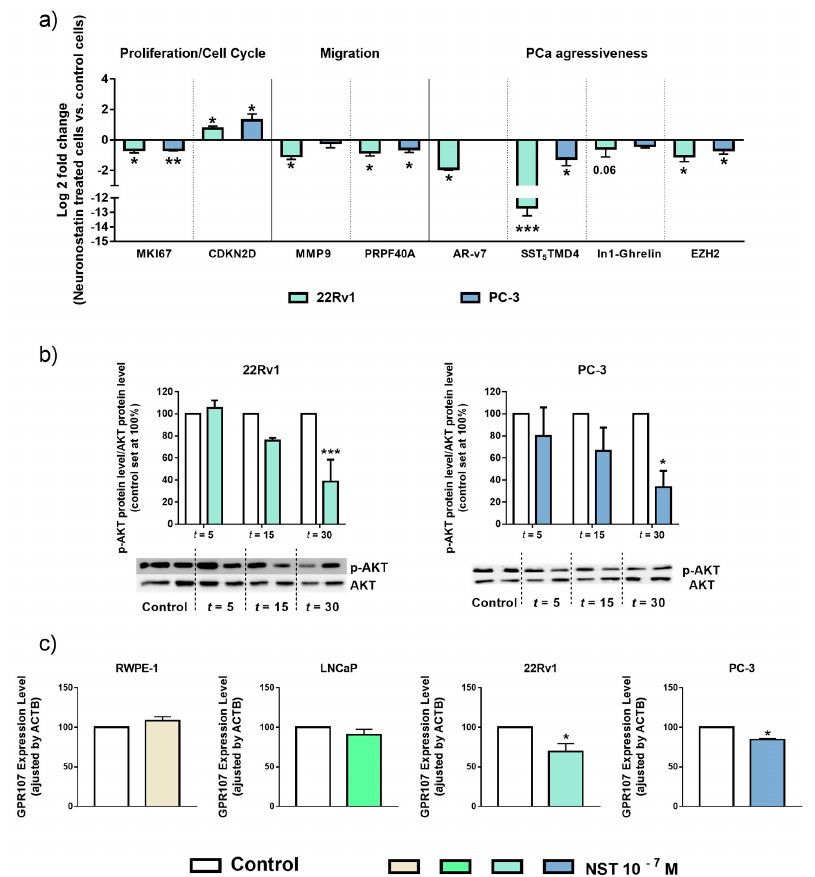
Figure 6. Molecular consequences of neuronostatin (NST) treatment in prostate cell lines. ( a ) Fold change of markers of proliferation (Marked of Proliferation Ki-67 (MKI67)), cell cycle inhibition (Cyclin Dependent Kinase Inhibitor 2D (CDKN2D)), migration (Matrix Metallopeptidase 9 and Pre-MRNA Processing Factor 40 Homolog A (MMP9 and PRPF40A, respectively)) and aggressiveness (Androgen Receptor variant 7 (AR-v7), Somatostatin Receptor 5 Transmembrane Domain 4 variant (SST 5 TMD4), Intron 1-retained ghrelin variant (In1-Ghrelin) and Enhancer Of Zeste Homolog 2 (EZH2)) in androgen-independent Prostate Cancer (PCa) cells (22Rv1 and PC-3) after NST treatment (10 − 7 M) compared to vehicle-treated cells. Messenger RNA (mRNA) levels were determined by quantitative Polymerase Chain Reaction (qPCR), adjusted by Actin Beta (ACTB) expression levels and represented as log2 of fold change of expression levels (NST-treated/vehicle-treated cells). ( b ) Protein levels of phospho-AKT in response of NST treatment in androgen-independent PCa cells (22Rv1 and PC-3) after 5 ( t = 5), 15 ( t = 15) and 30 ( t = 30) minutes of exposition. Phospho-AKT (p-AKT) levels were normalized by total AKT protein levels. Protein data were represented as percent of vehicle-treated cells (set at 100%). ( c ) GPR107 expression levels after 24 h of NST treatment in prostate cell lines. mRNA levels of GPR107 were determined by qPCR and adjusted by ACTB expression levels. Asterisks (* p < 0.05; ** p < 0.01 and *** p < 0.001) indicate statistically significant differences between NST treatment and vehicle-treated cells.